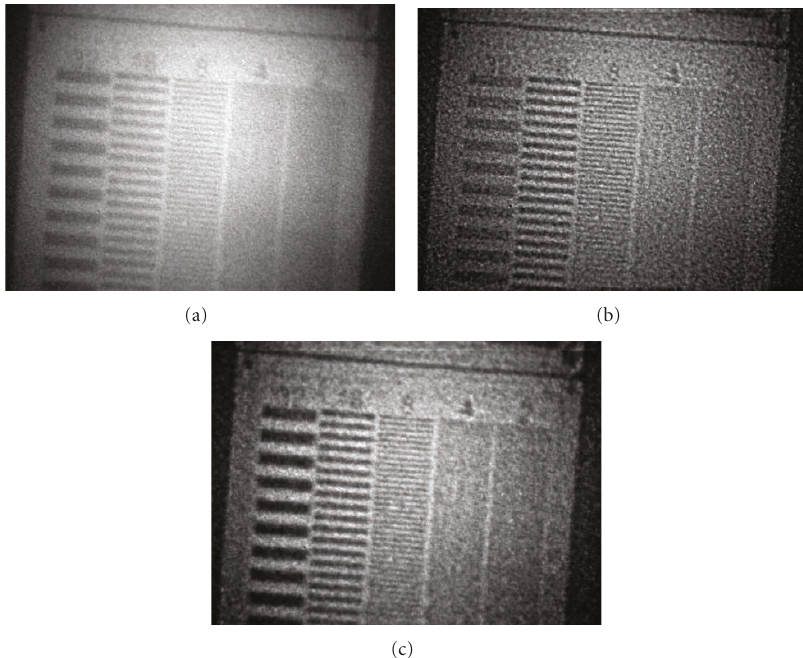
Figure 3: Image taken at 7.5m depth in Florida. The original (a), the restored image based on measured MTF (b) and the restored image based on modeled MTF (c). Courtesy of Hou et al.